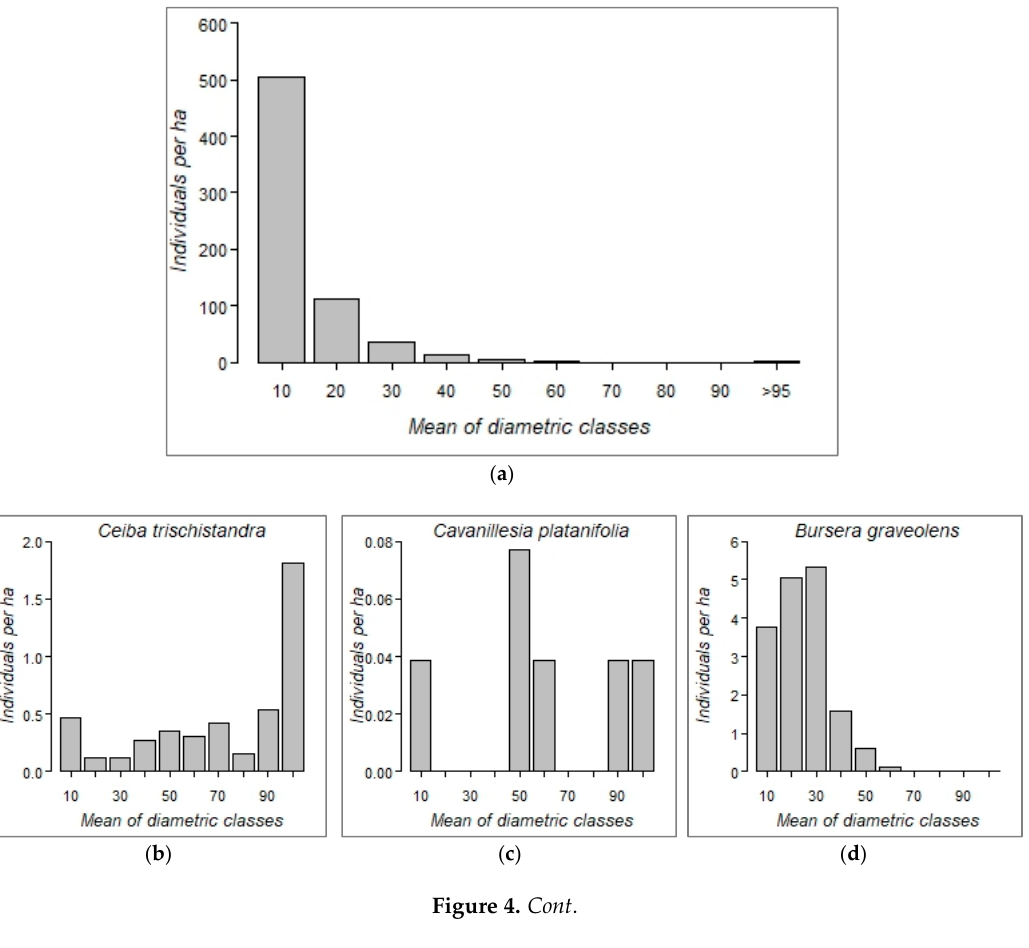
Figure 3. Current diversity and structure situations of the forests in the study area: ( a , c – f ) ranges of species parameters in the plots; ( b ) species accumulation curve obtained via the Coleman method with confidence of 95% (grey